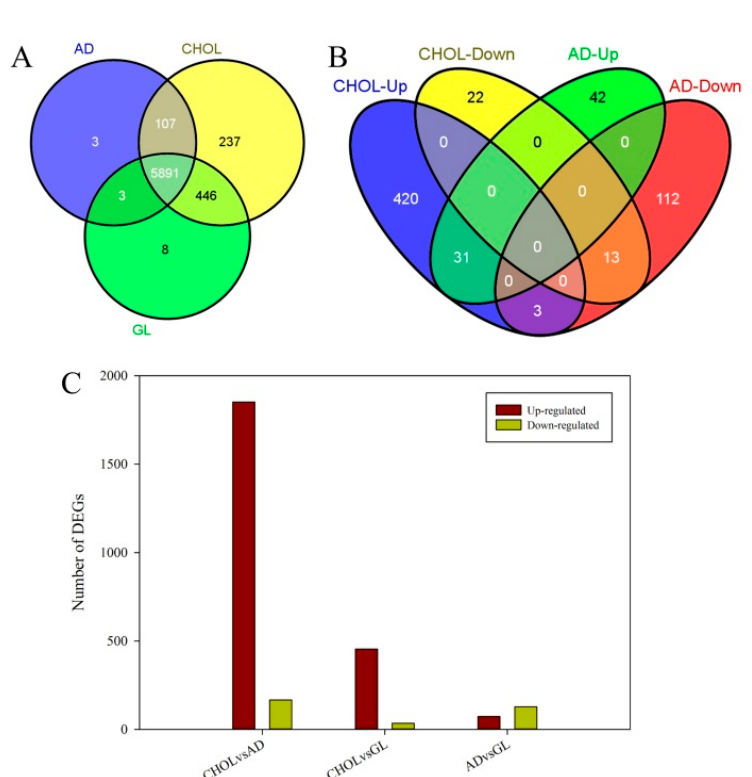
Figure 1. Genes expression profiling in different M. smegmatis samples. ( A ) Overlap examinations were performed basing on the resulting gene lists of three samples by VENNY [33]; ( B ) overlap examinations of differentially expressed genes (DEGs) identified between cholesterol and glycerol, androstenedione and glycerol; ( C ) DEGs identified pair-wisely among three samples. AD, CHOL and GL correspond to three different conditions: 20 mL minimal medium plus with 1.75 mM androstenedione, 1.29 mM cholesterol and 5.47 mM glycerol respectively, respectively. CHOL-Up, CHOL-Down, AD-Up and AD-Down correspond to the DEGs up-regulated or down-regulated by CHOL or AD when compared with